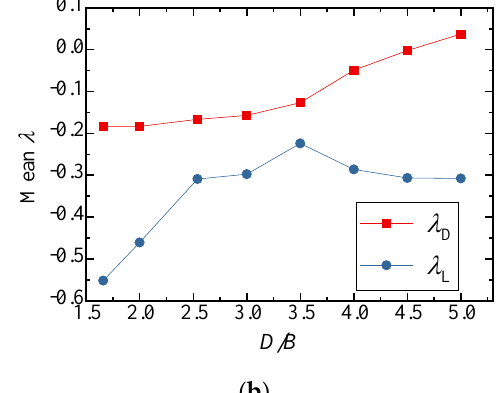
Figure 21. PSD of the lift coefficient for Case 3: ( a ) Vehicle; ( b ) Upstream bridge; ( c ) Downstream bridge.